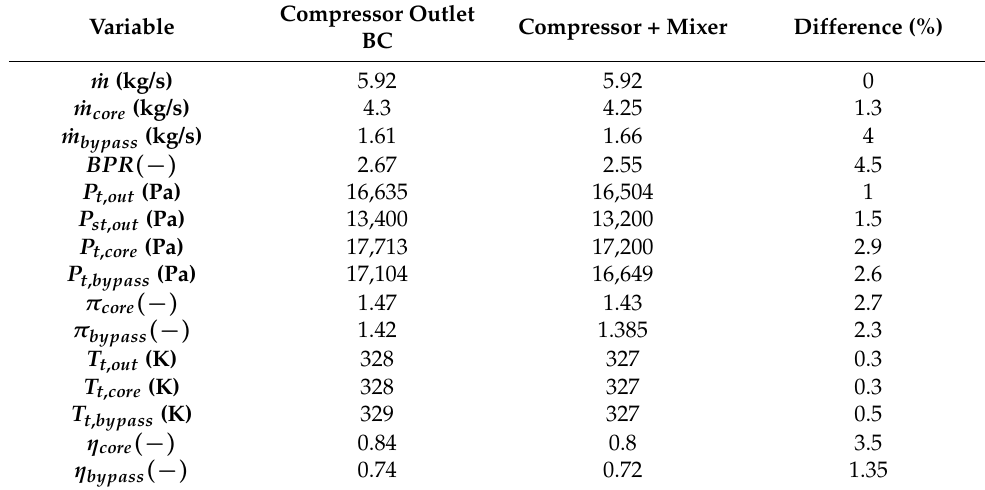
Table 6. Flow conditions at the interface between the compressor and the